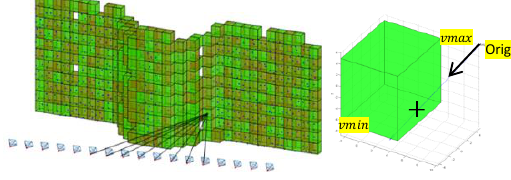
Figure 7. Voxel-ray intersection for visibility